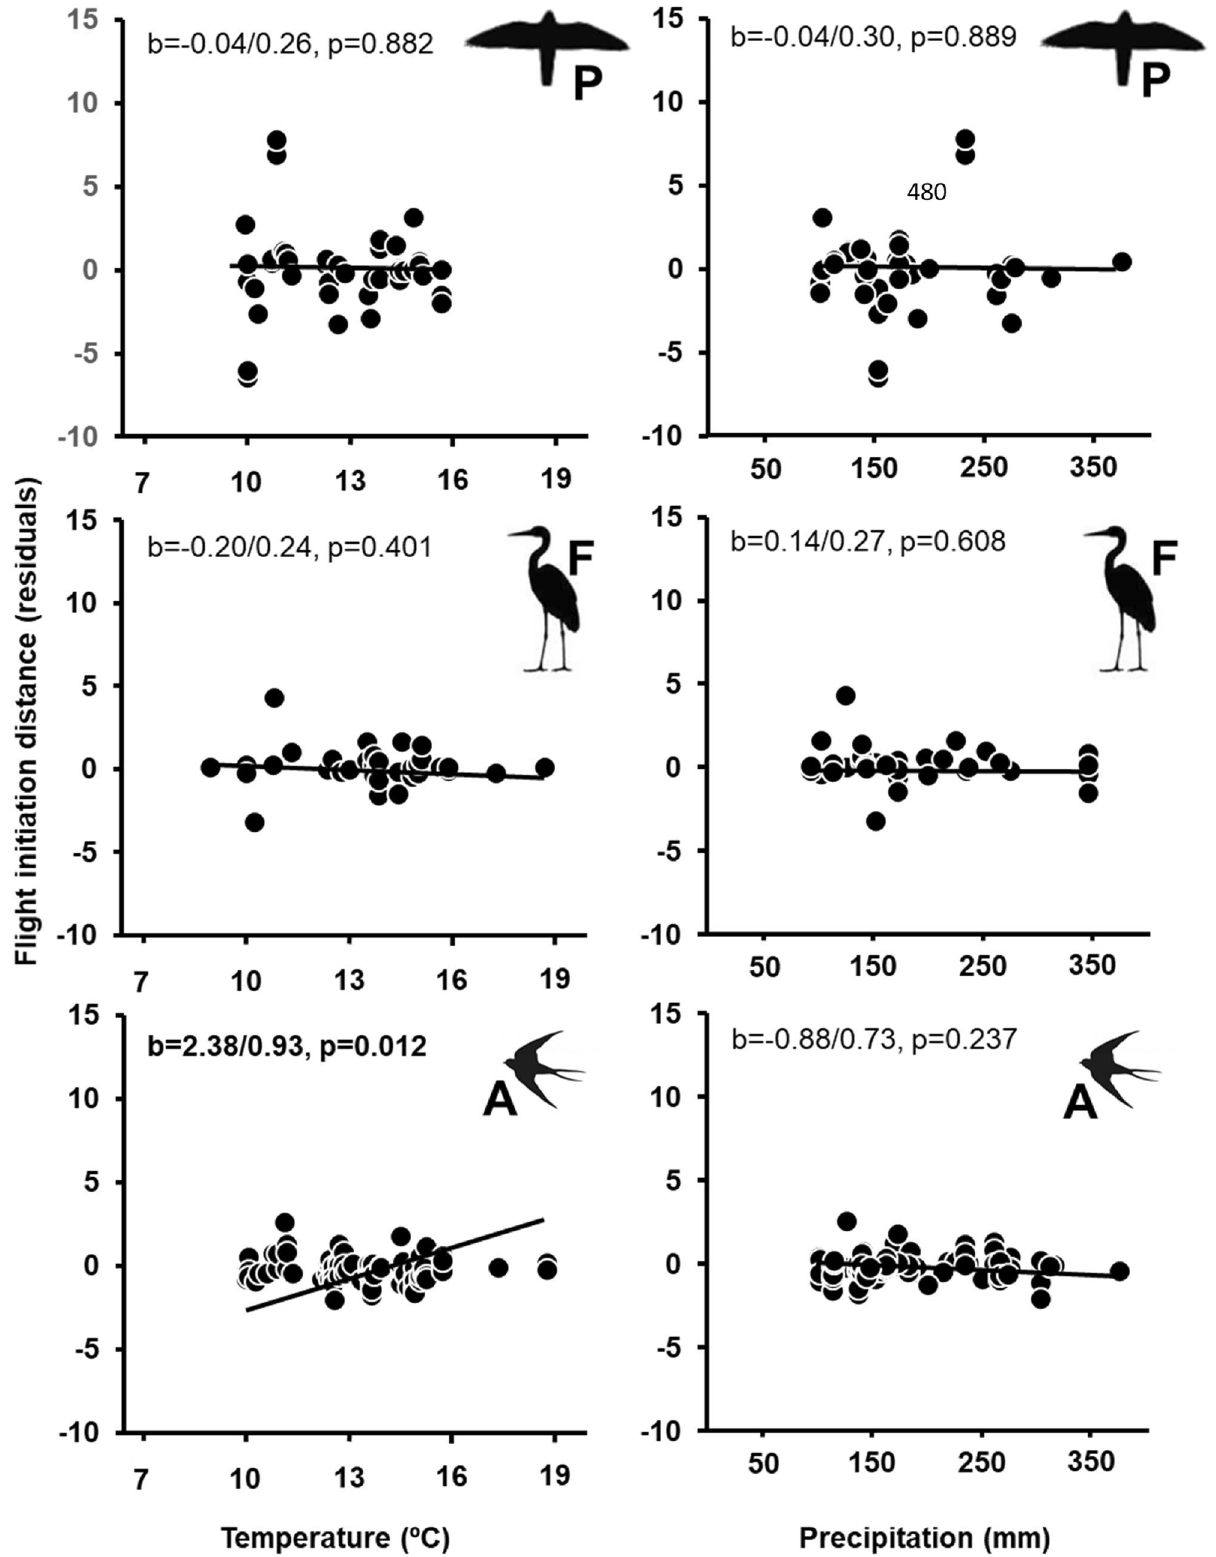
Figure 2. Relationships among mean spring temperature or precipitation during the local breeding season, and mean flight initiation distances (FID, corrected for the effects of species, site, year, latitude and body mass) in rural habitats according to diet ( P predator, F piscivore, I insectivore, A aerial feeder, H herbivore, O omnivore; silhouettes of representative species of each group are included). Standardized regression coefficents (β/SE) and their p values are also given. Significant effects (p < 0.05) are in